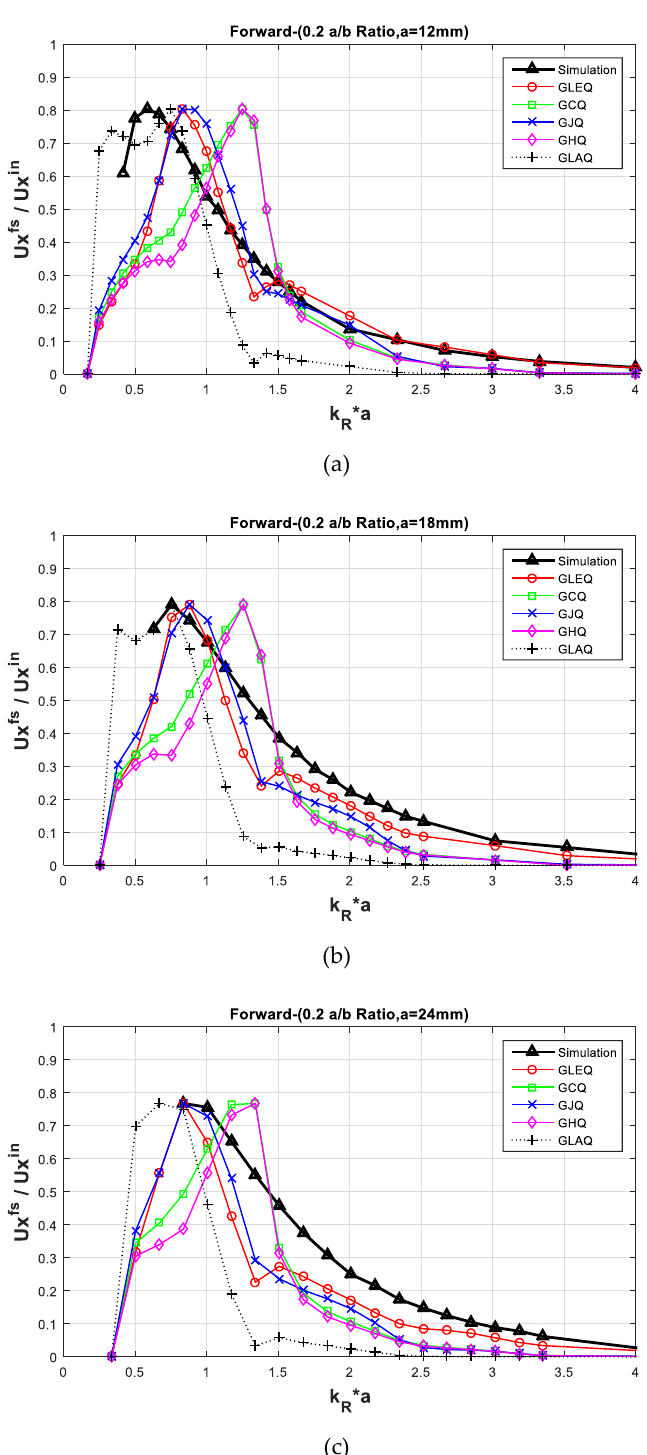
Figure 5. Displacement variation curves of analytical model solving five di ff erent integral methods and FE simulation shown with di ff erent crack depths, ‘a ’ of the forward scattered models: ( a ) result with a 12 mm a and a 0.2 a / b ratio model (C12–0.2), ( b ) results with an 18 mm a and 0.2 a / b ratio model (C18–0.2) and ( c ) results with 24 mm of a and a 0.2 a / b ratio model (C24–0.2). The figure implies the deeper crack depth which is a higher ‘a’ result shows the peak point at the higher k R a